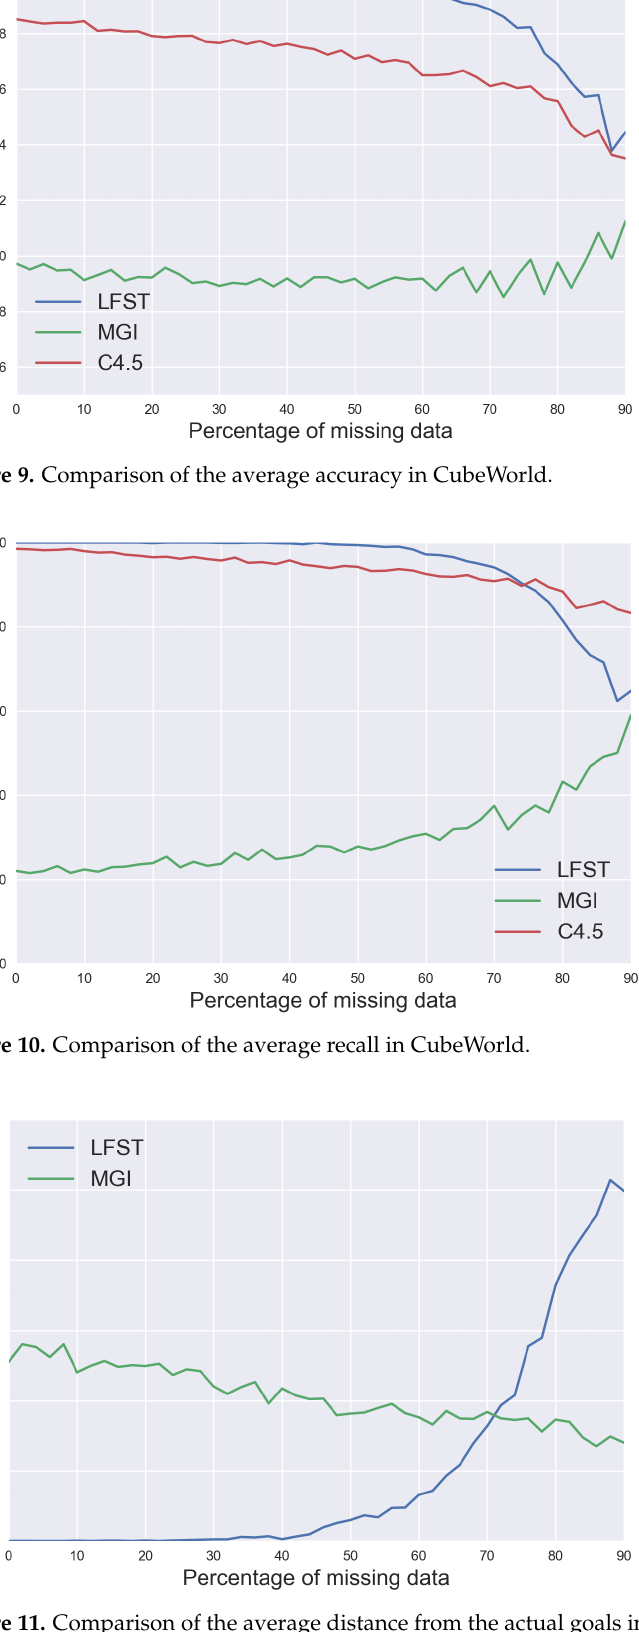
Figure 11. Comparison of the average distance from the actual goals in